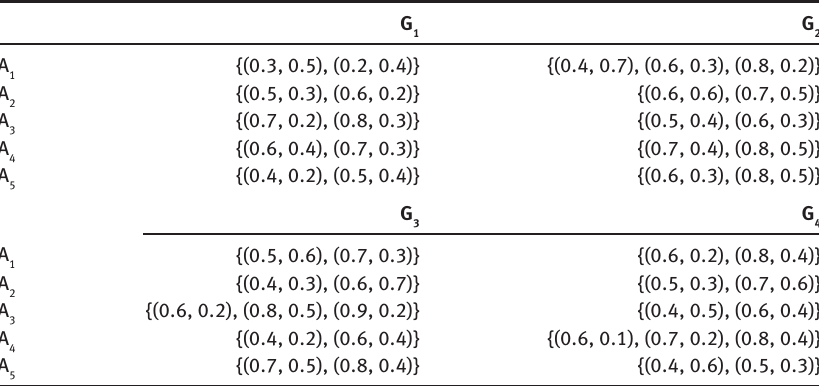
Table 1: Pythagorean Hesitant Fuzzy Decision Matrix.